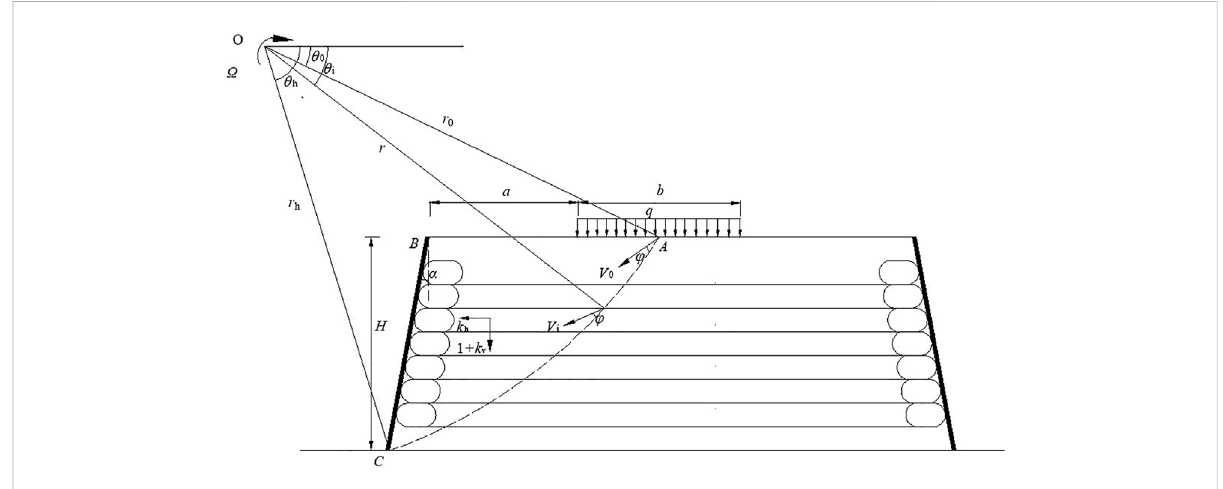
FIGURE 2 Analysis model of log-spiral failure